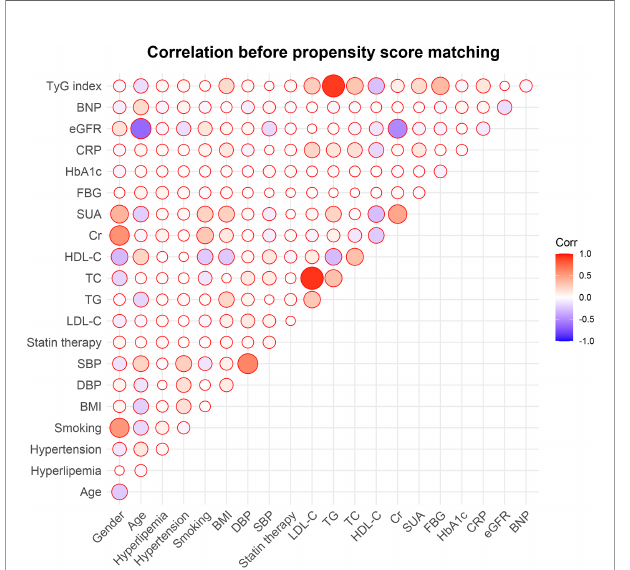
FIGURE 3 | Correlations between the TyG index and traditional cardiovascular risk factors. TyG, triglyceride-glucose; BNP, brain natriuretic peptide; eGFR, estimated glomerular fi ltration rate; CRP, C-reactive protein; HbA1c, glycosylated hemoglobin A1c; FBG, fasting blood glucose; SUA, serum uric acid; Cr, creatinine; HDL-C, high density lipoprotein cholesterol; TC, total cholesterol; TG, triglyceride; LDL-C, low-density lipoprotein cholesterol; SBP, systolic blood pressure; DBP, diastolic blood pressure; BMI, body mass index.